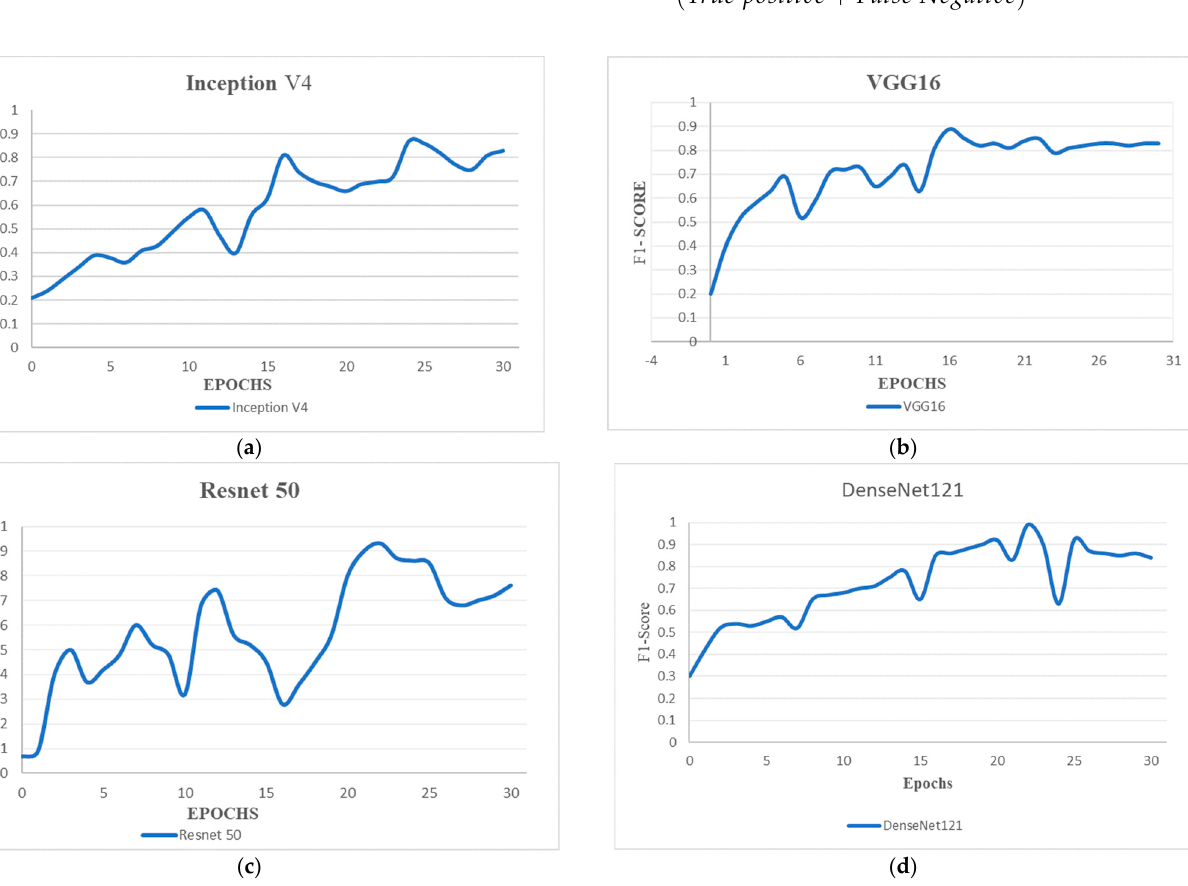
Figure 9. F1 score vs. validation scores using PlantVillage dataset for ( a ) Inception V4; ( b ) VGG-16; ( c ) ResNet-50; ( d ) DenseNet-121.